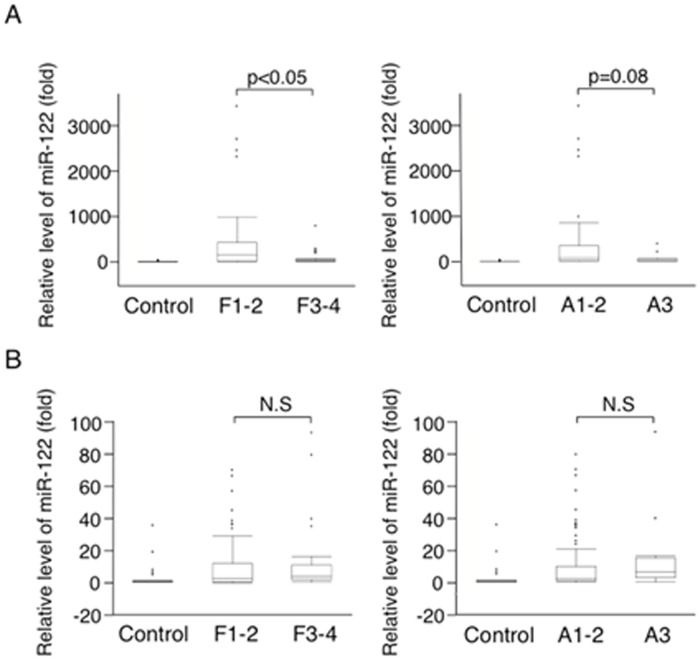
Serum miR-122 levels in the patients with HBV (A) or HCV infection (B).Liver fibrosis staging: F1, fibrous expansion of portal area; F2, fibrous expansion of portal area with portal-to-portal bridging fibrosis; F3, marked bridging fibrosis with occasional nodules; or F4, cirrhosis. Grading of the activity of liver inflammation: A1, mild; A2, moderate; or A3, severe [21,22].